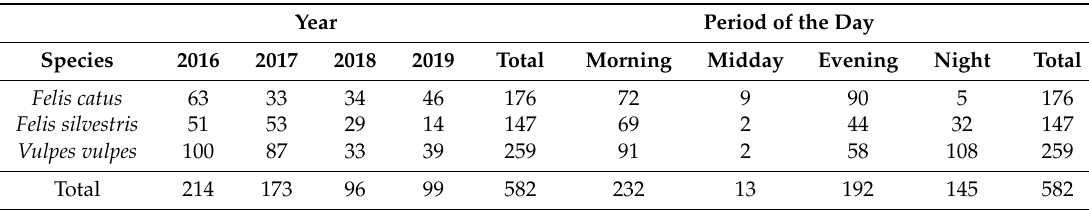
Table 1. Number of domestic cats, European wildcats and red foxes observed each year and during the di ff erent periods of the day.